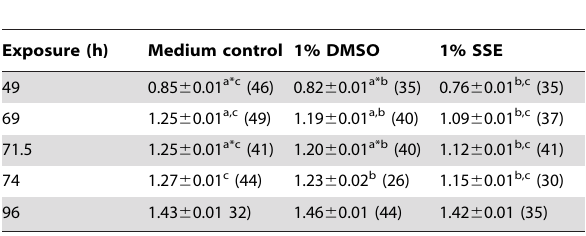
Table 2. Length (mm) of nematodes exposed to 1% SSE, 1% DMSO or medium alone from the L1